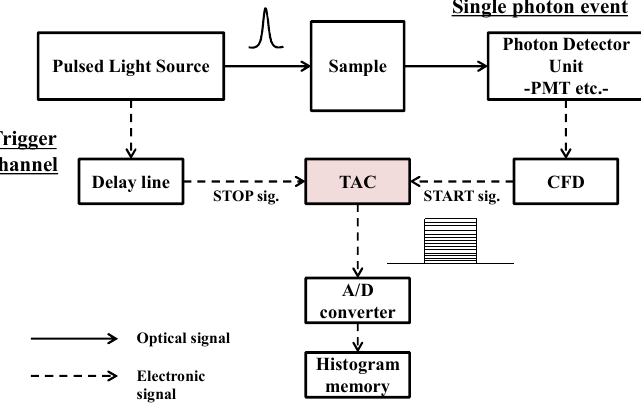
Figure 7. Block diagram of a standard time-correlated single-photon counting (TCSPC) instrument.